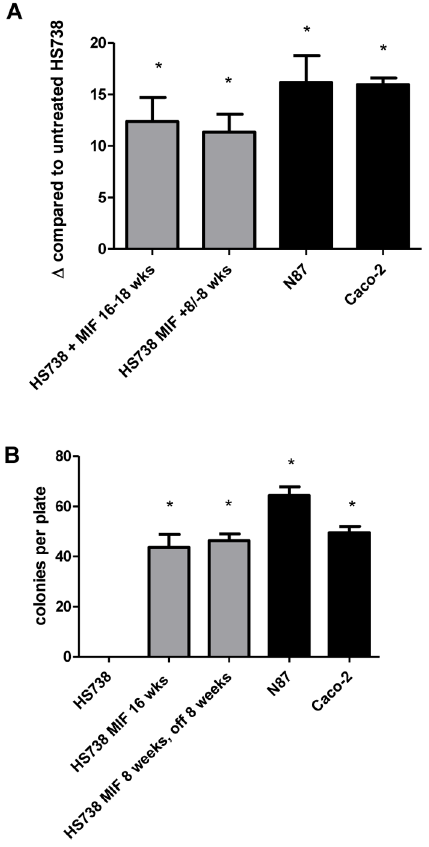
Figure 6. Chronic MIF exposure induces HS738 cell transfor- mation. HS738 chronic exposure to MIF induces A) upregulation of TERT gene expression so similar levels as N87 control cells and B) colony formation in a focus forming assay. N=8 and the mean 6 standard error are shown as the results of duplicated in multiple experiments. * p ,